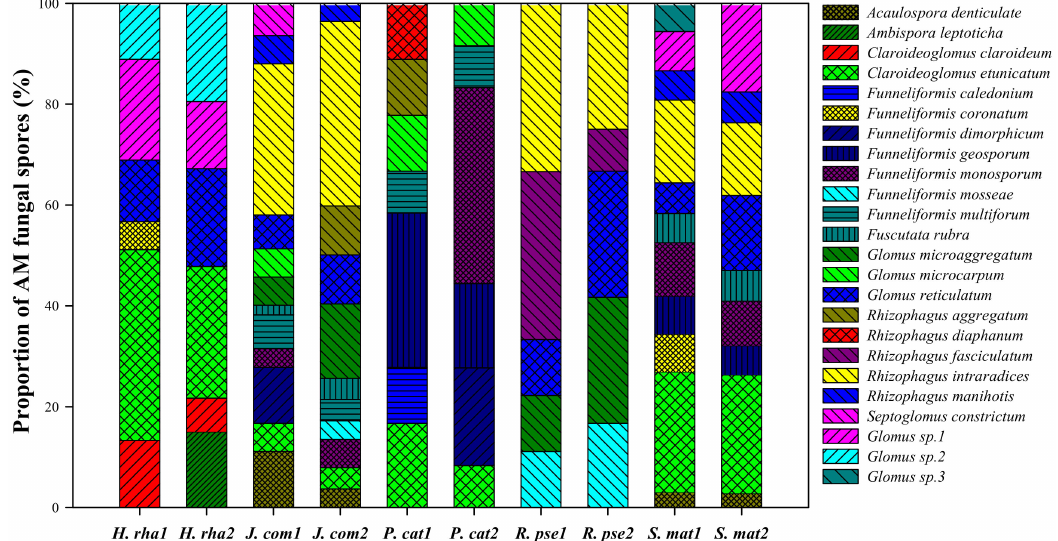
Figure 2. Proportion of arbuscular mycorrhizal (AM) fungal spores in the rhizosphere of five dominant tree species. Tree species: H. rha , Hippophae rhamnoides ; J. com , Juniperus communis ; P. cat , Populus cathayana ; R. pse , Robinia pseudoacacia ; and S. mat , Salix matsudana. Soil depths: 1, 0–20 cm and 2, 20–40